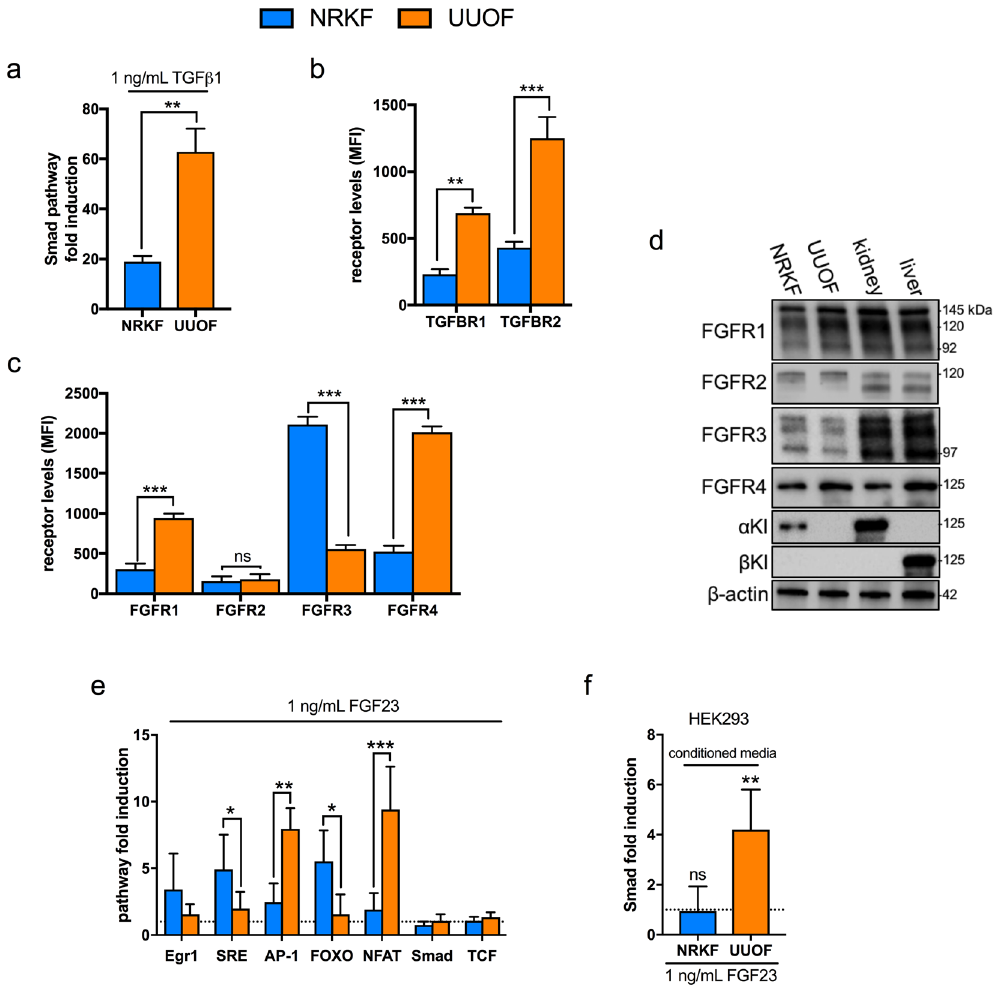
Figure 6. Differential expression of TGF β and FGF receptors in NRKF and UUOF. (a ) Fold change in TGF- β 1 bioactivity in NRKF and UUOF transiently transfected with a Smad- responsive luciferase construct in response to treatment with exogenous TGF- β 1 (1 ng/mL for 30 min). ( b ) Quantitative flow cytometric analysis of the cell-surface expression of TGFBR1 and TGFBR2 in NRKF and UUOF. ( c ) Quantitative flow cytometric analysis of the cell-surface expression of FGFR1, FGFR, FGFR2, FGFR3 and FGFR4 in NRKF and UUOF. ( d ) Representative Western blot analysis of FGFR1-4 and co-receptor α and b Klotho (Kl) protein expression in UUOF and NRKF compared to rat tissue levels. β -tubulin was used as a loading control. ( e ) Comparative acute effects (30 min) of exogenous FGF23 (1 ng/mL) on signal transduction pathways in NRKF and UUOF transiently transfected with specific transcription factor responsive luciferase constructs. Results are expressed relative to vehicle-treated cells (dotted line). Pathways examined were early growth response 1 (Egr1), MAPK/ ERK pathway (serum response element; SRE), MAPK/JNK (AP-1), PI3K/Akt (FOXO), Ca 2 + /PKC (NFAT), TGF- β (Smad), Wnt (T-cell factor; TCF). ( f ) Relative changes in Smad activation (TGF- β bioactivity) in HEK293 cells treated with media from NRKF and UUOF conditioned by exposure to FGF23 (1ng/mL for 24 h) or vehicle (dotted line). Data are shown as mean ± SD and represent at least three independent experiments with similar results. * P < 0.05; ** P < 0.01; *** P < 0.001; ns, not significant. P-values were determined using Student’s unpaired two-tailed